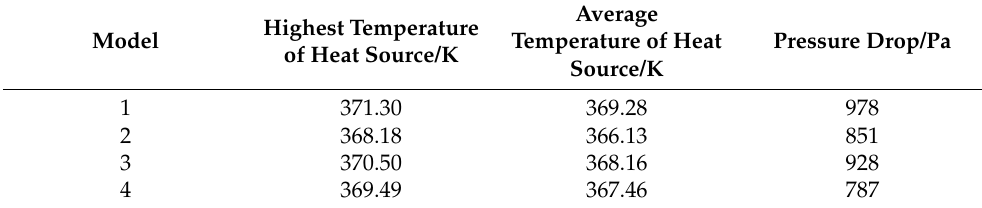
Figure 10. Vapor − phase distribution of di ff erent channel size; ( a ) 4 mm × 3 mm; ( b ) 6 mm × 3 mm.